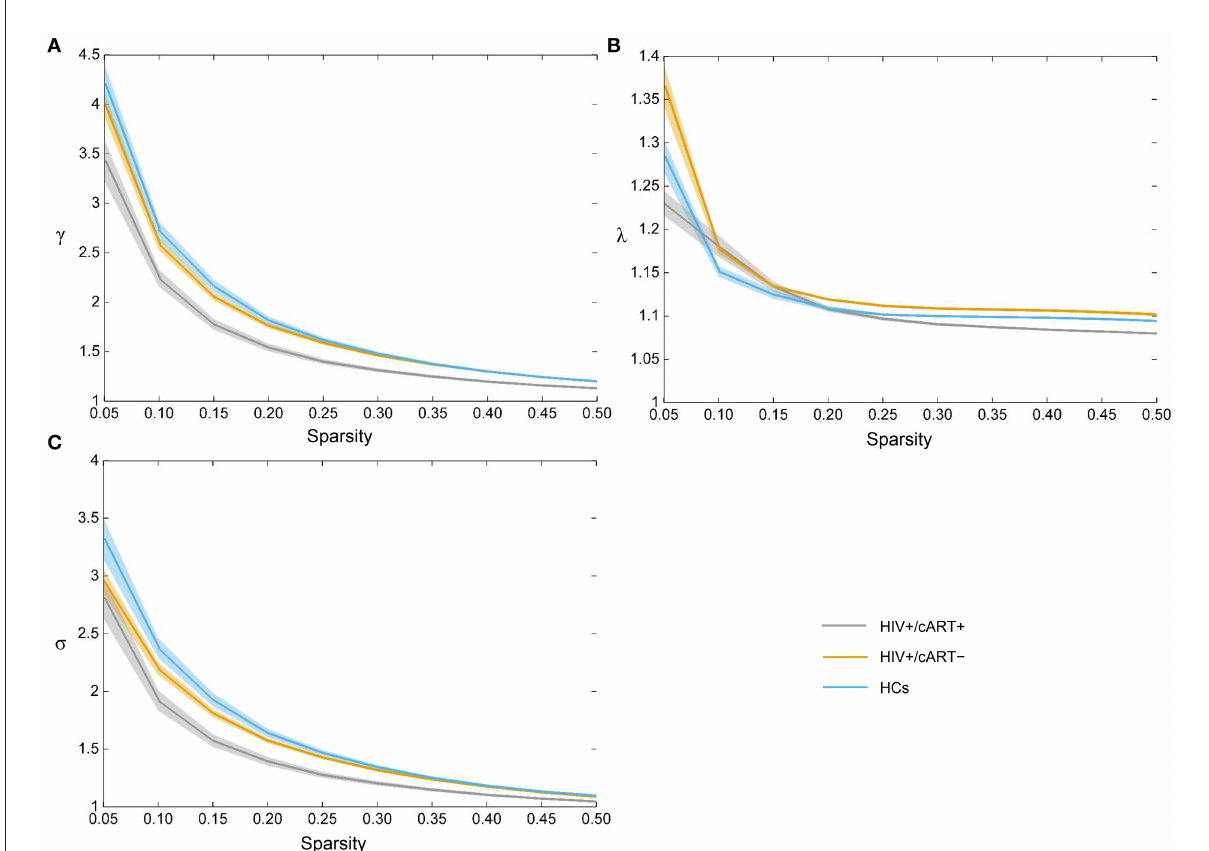
FIGURE5 All three groups exhibited the typical features of small-worldness (A) γ > 1, (B) λ ≈ 1, and (C) σ > 1. γ , normalized clustering coefficient; λ , normalized characteristic path length; σ ,